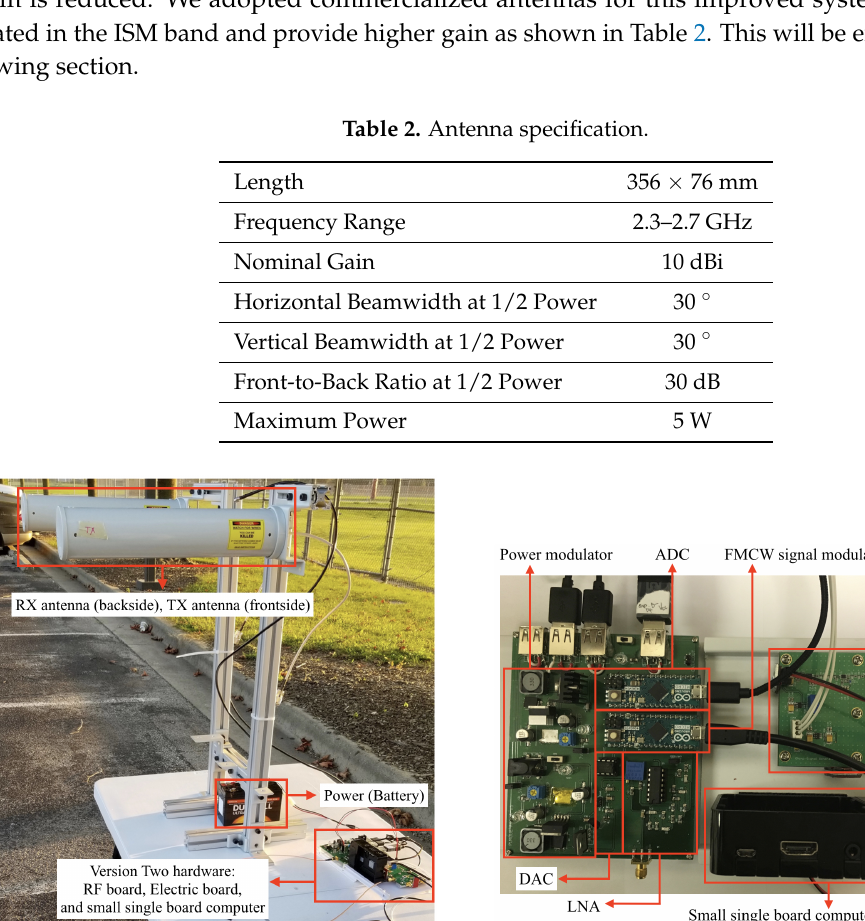
Figure 3. Version two hardware including antennas ( left ). Version two hardware of electric parts ( right